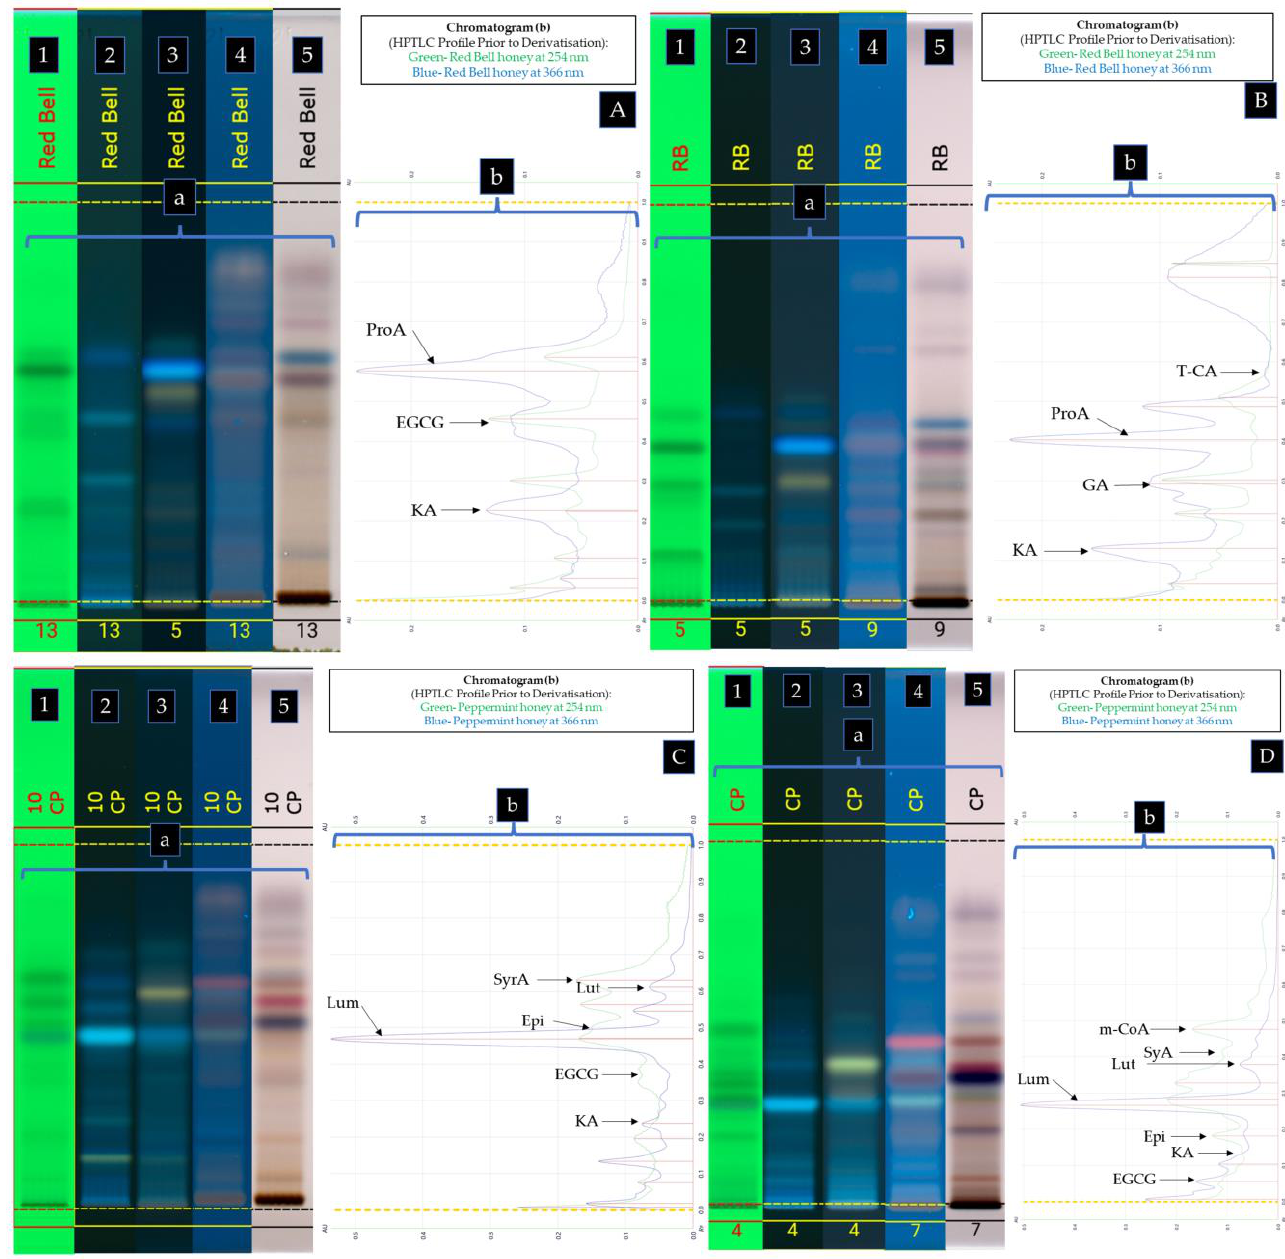
Figure 3. HPTLC Profile of Calothamnus spp. (Red Bell) honey ( A , B ) and Agonis flexuosa (Coastal